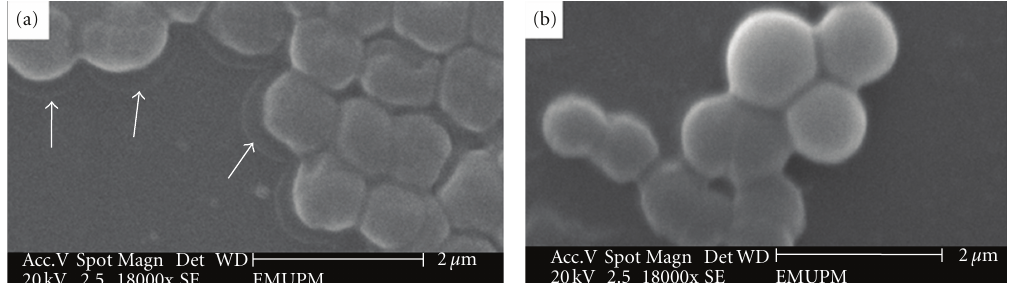
Figure 5: A scanning electron micrograph illustrating the appearance of thick extracellular products in strongly, moderately, and weakly adherent isolates (a) and the absence of those products in the non-adherent Staphylococcus epidermidis ATCC 12228 reference strain (b).